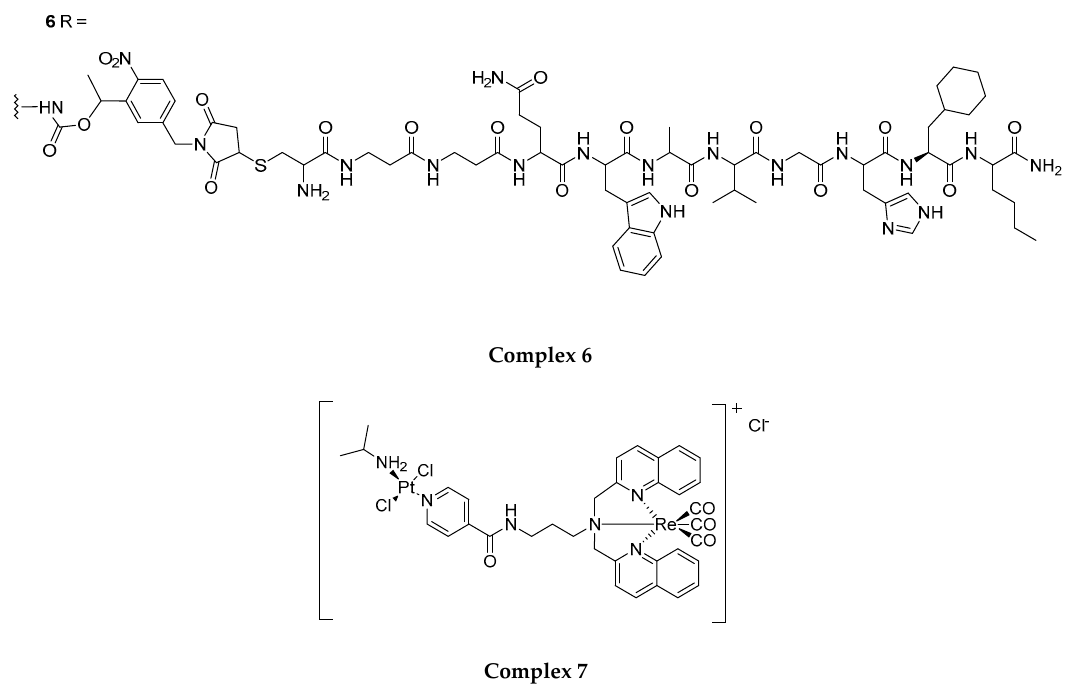
Figure 4. A series of different ligands complexed to the Re(I) tricarbonyl core forming different Re(I) tricarbonyl complexes with different phototoxic activity on cancer cell lines.